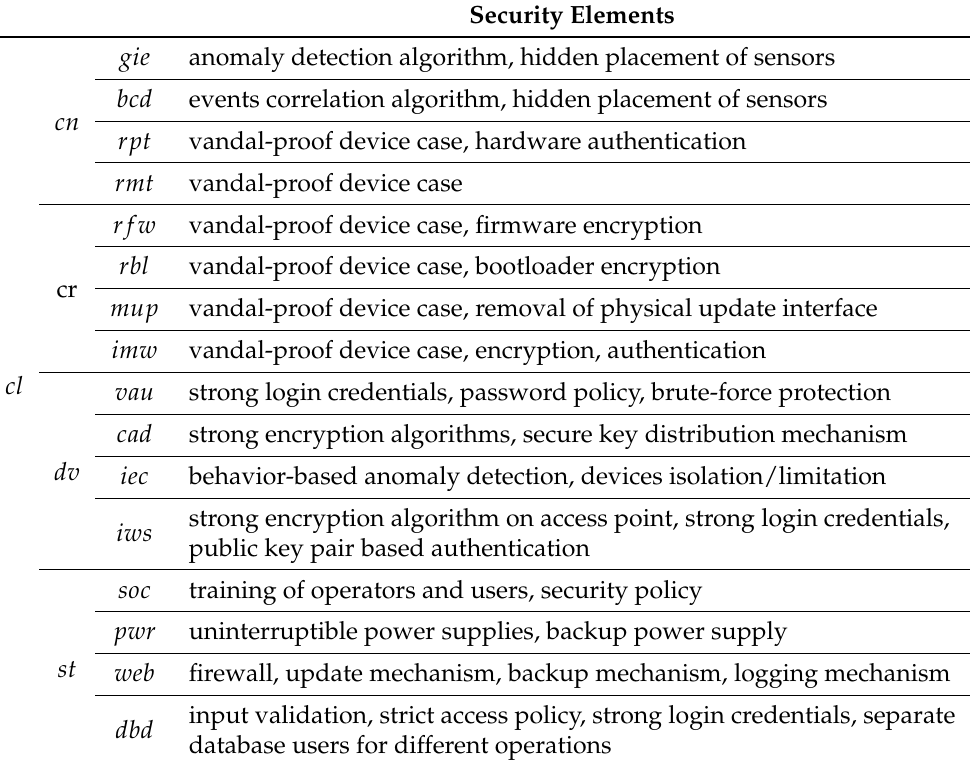
Table 6. Classes of attack actions and security